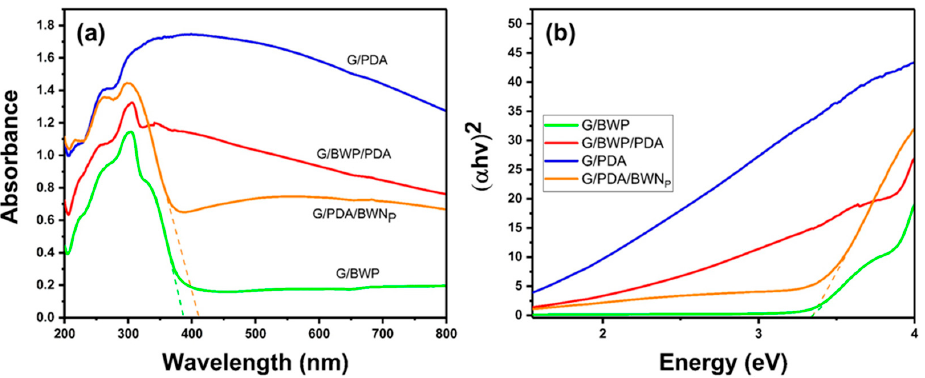
Figure 6. ( a ) Diffuse reflection spectra (DRS) ( b ) Tauc plot of G/BWP, G/BWP/PDA, G/PDA, and G/PDA/BWN P .